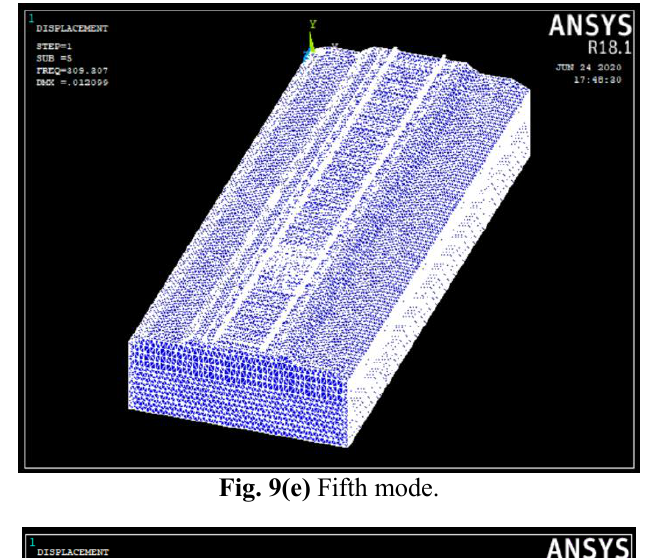
Fig. 9(e) Fifth mode.